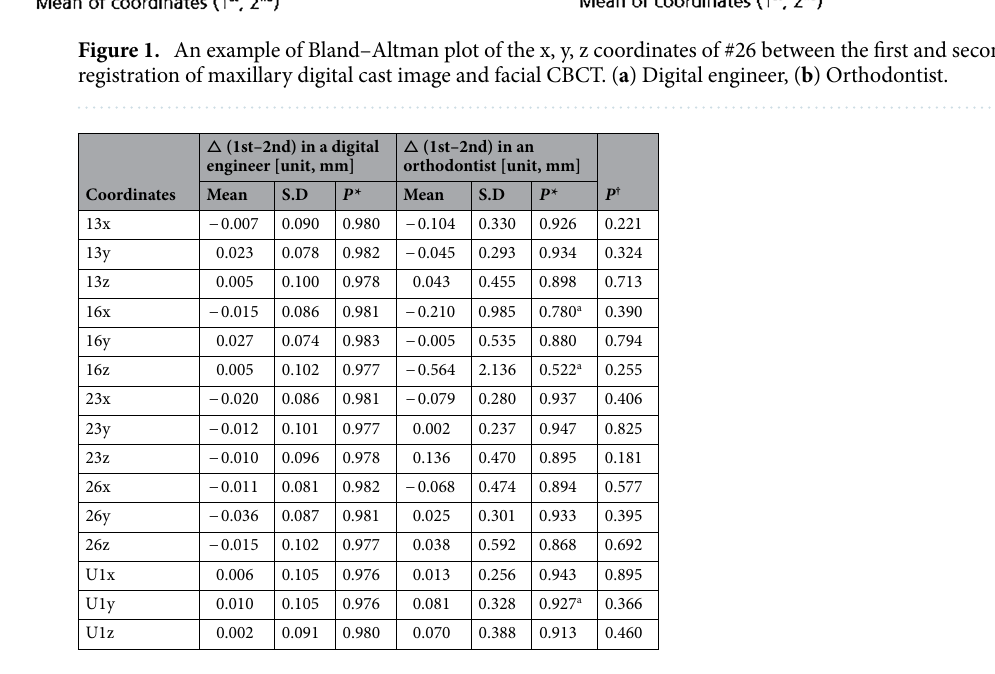
Table 2. Descriptive statistics showing the mean differences in x, y, and z coordinates of each tooth between first registration and second registration of digital maxillary cast images and facial CBCTs in a digital engineer and an orthodontist. △ (1st–2nd), the mean difference in x, y, and z coordinates of each tooth between first registration (1st) and second registration (2nd) of digital maxillary cast images and facial CBCT images. S.D. standard deviation. *Paired t test. † Independent t test. a Wilcoxon Signed-rank test.